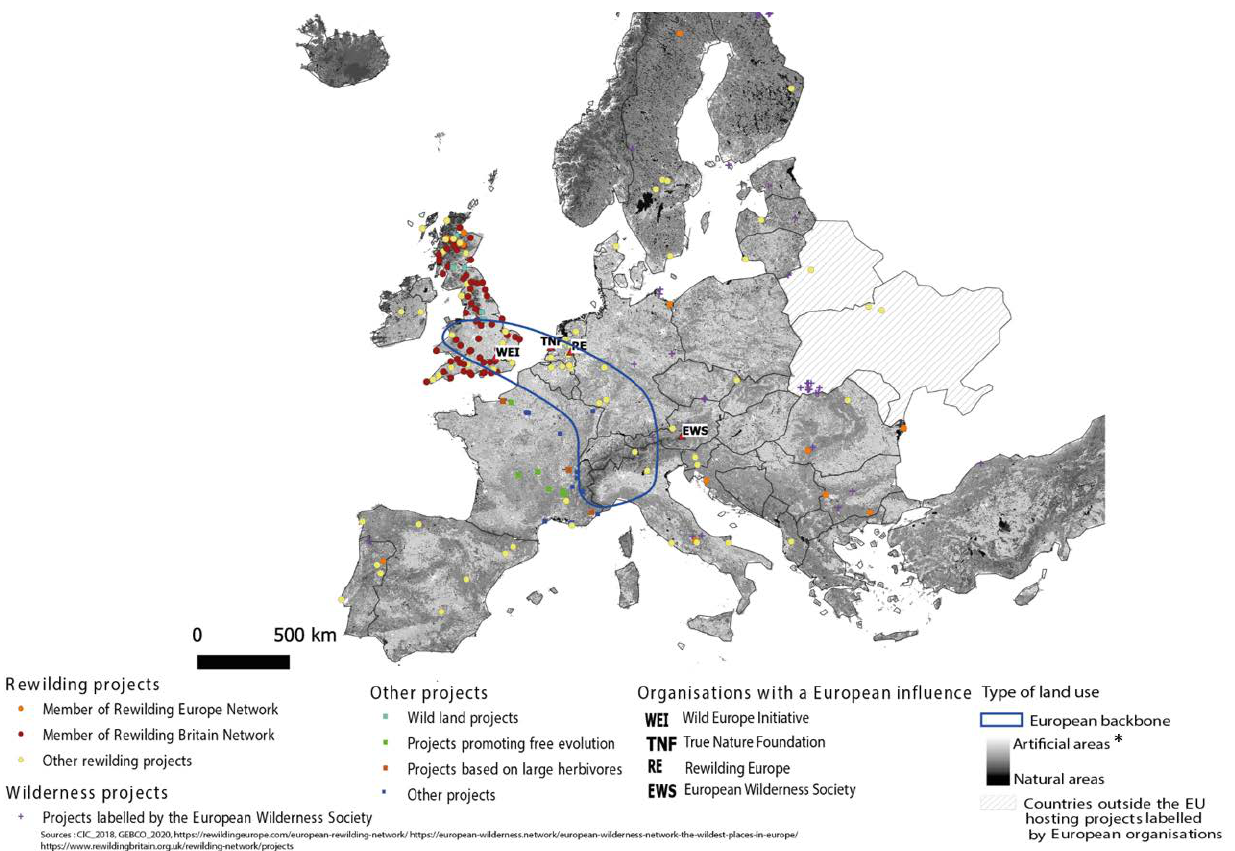
Figure 1. Map of projects in favour of wild nature in Europe. * Data from the Corine Land Cover database, which lists the different types of land use in Europe. Based on the different categories of the database, the data here were distributed along a gradient from the most artificial spaces to semi-natural to natural